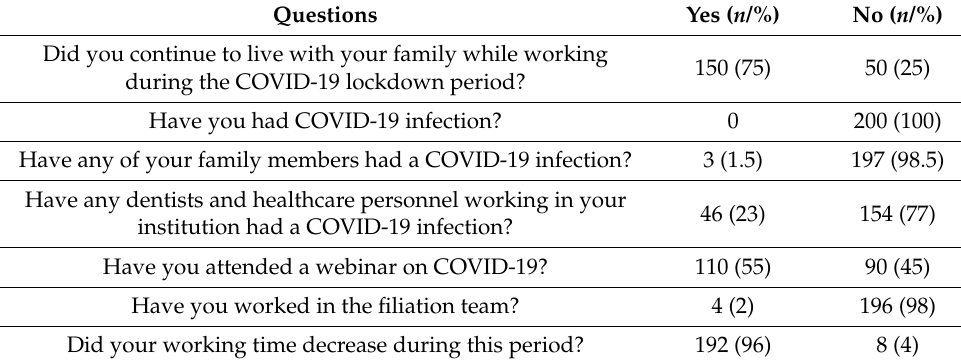
Table 2. Participants’ working experience during the COVID-19 pandemic